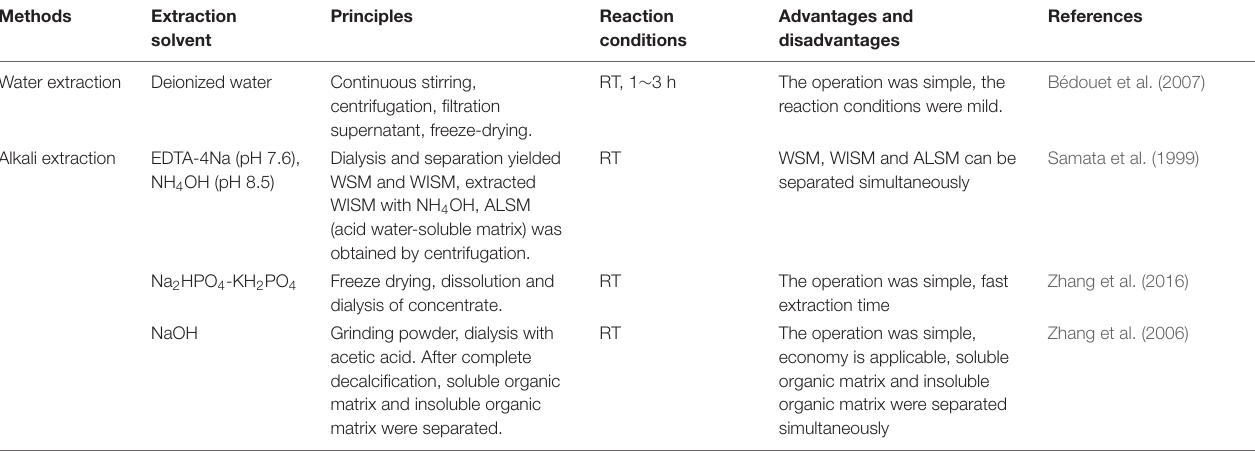
TABLE 3 | Summary of the extraction and purification processes of nacre powder matrix